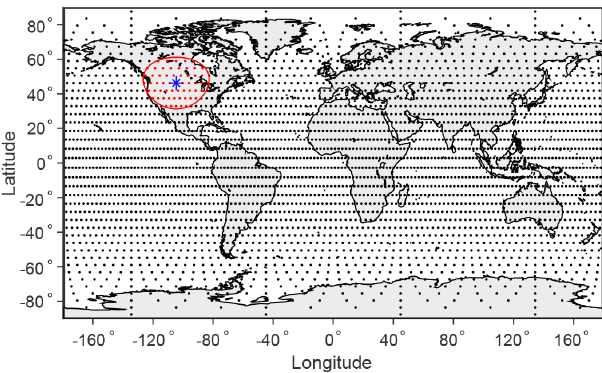
Figure 1. Example of a uniform global grid created using the methodology introduced in Rosca (2010). There are 3200 grid points based on a 40 × 40 grid in each hemisphere. The red cir- cle is an example subdomain for the local MAPE calculation with a geodesic radius of 15 ◦ (1670km) centered on the location marked with a blue asterisk and including all grid points colored in red. Ex- cept where noted, MAPE results in figures and tables are based on this horizontal grid at 15 vertical pressure